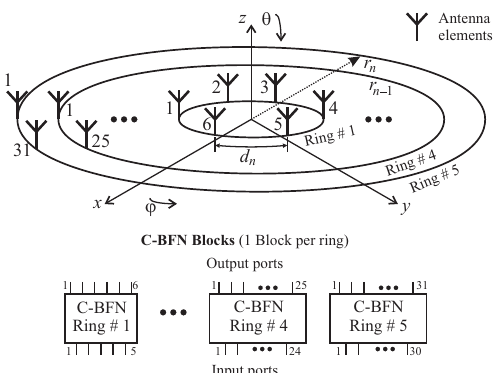
Figure 3. Schematic of the dual-beam array feed network subsystem and the aperiodic antenna array